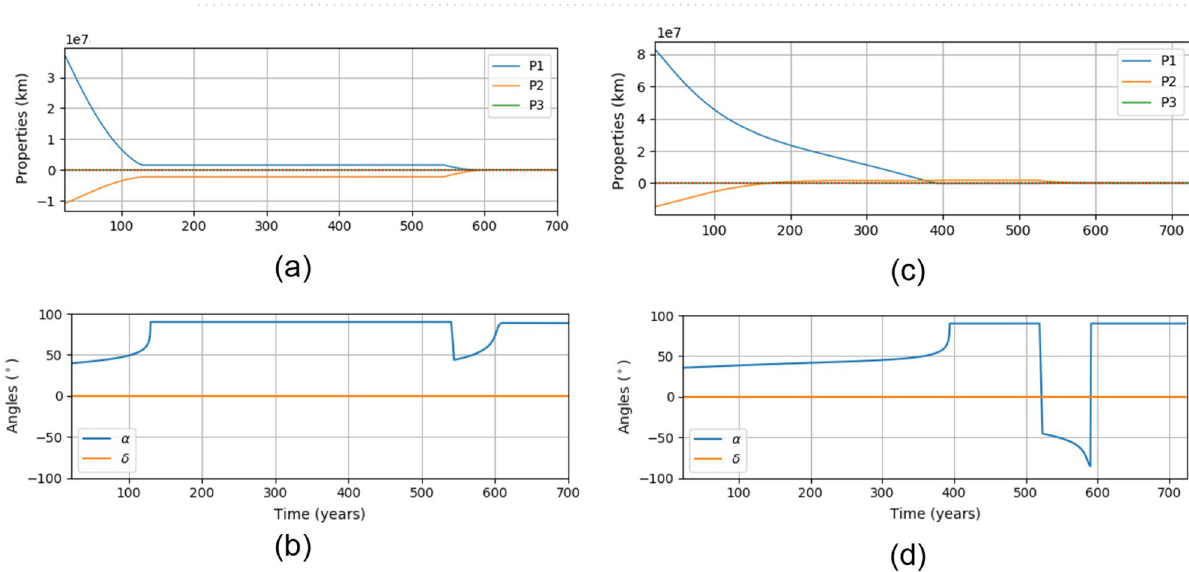
Figure 5. Heliocentric trajectories for the spacecraft with and without sail. ( a ) Tof of 700 days. ( b ) Tof of 725 days.